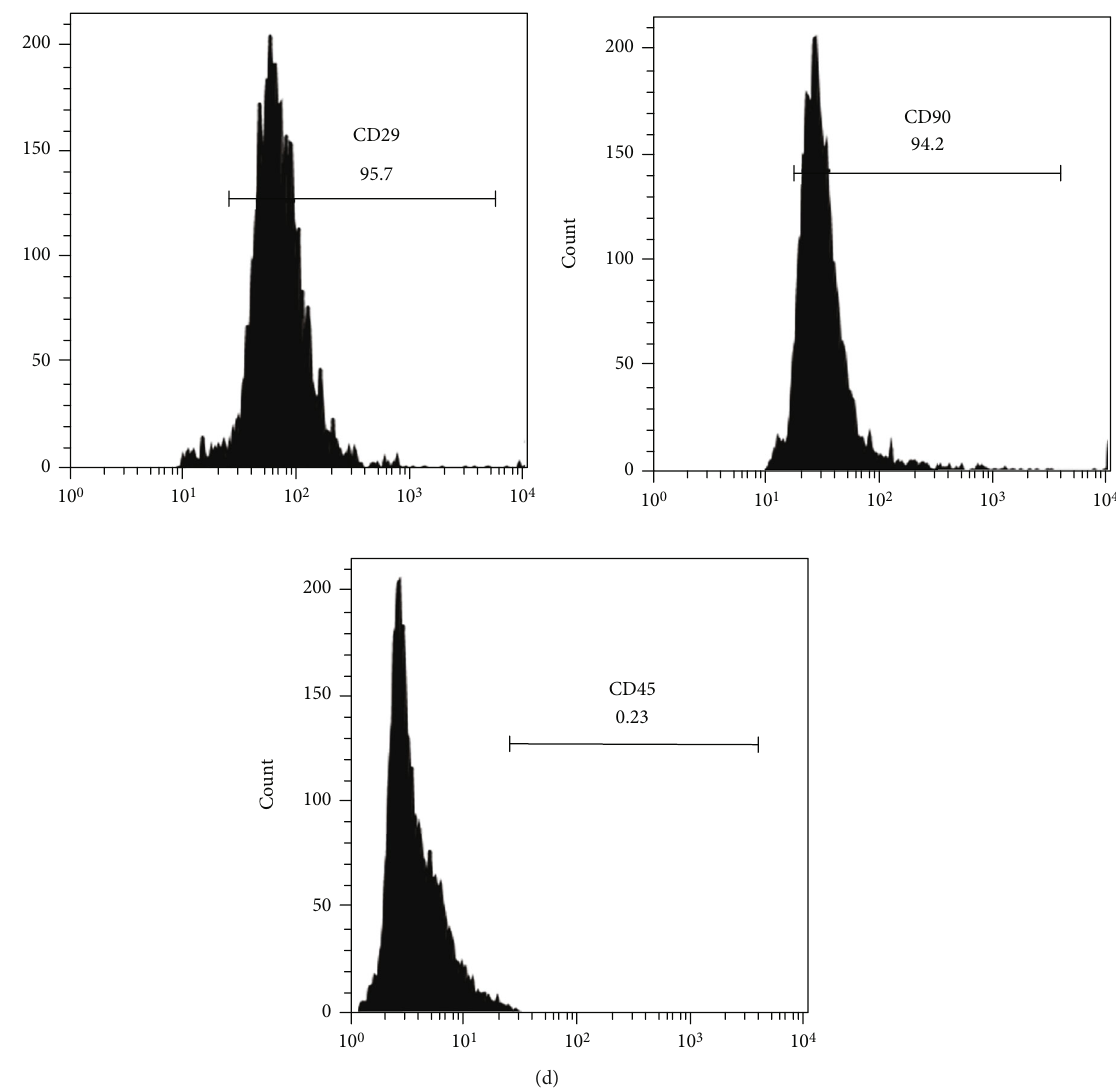
Figure 1: BMSC isolation and determination. (a) Cell morphology of cultured BMSCs. Scale = 100 μ m . (b) Adipocytes stained with Oil Red O. Scale bar = 50 μ m . (c) Osteoblasts stained with Alizarin Red. Scale = 50 μ m . (d) CD29, CD90, and CD45 expression as determined using fl ow